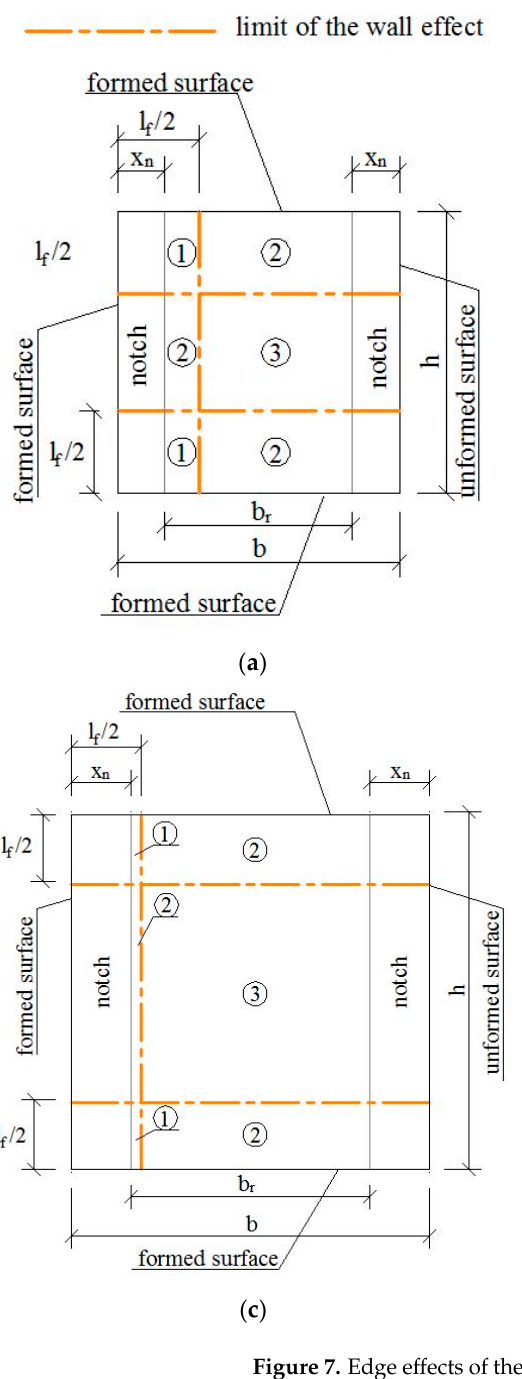
Figure 6. Edge effects of the sawing and wall on the cross-section areas of the prisms from the mock- up: ( a ) 6W, ( b ) 8W, ( c ) 9TF and ( d ) 12TF.